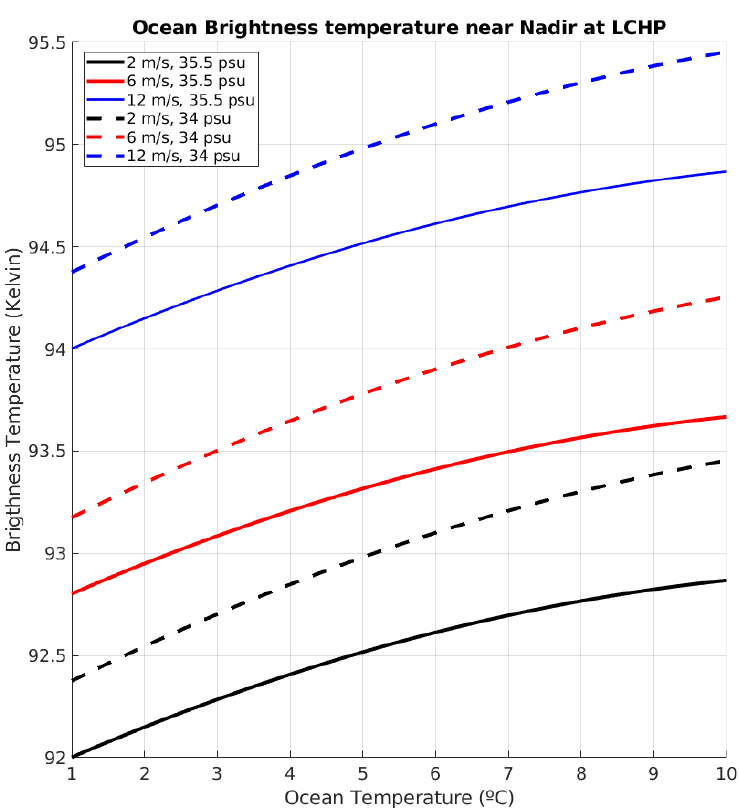
Figure 9. Brightness temperature for different psu (34 and 35.5 psu), temperatures (1 ◦ C to 10 ◦ C), and wind speeds (from 2 m/s to 12